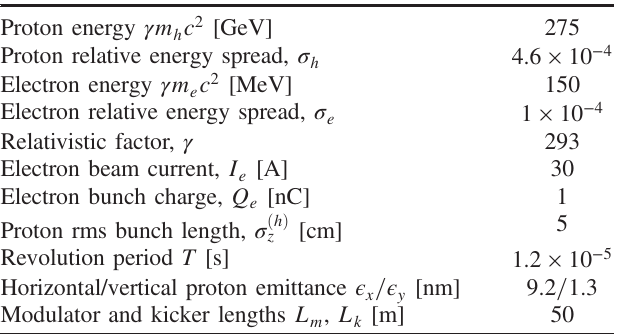
TABLE I. Parameters of the eRHIC collider with a hypothetical MBEC cooling